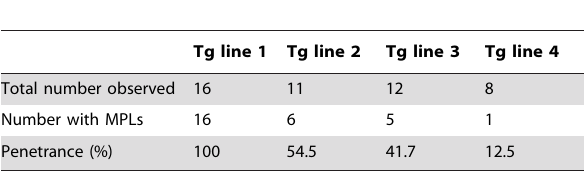
Table 1. Penetrance of melanophore proliferative lesions (MPLs) among Tg(tyr:HRAS G12V ) / Tg(hsp:cre) double-transgenic medaka derived from four different Tg(tyr:HRAS G12V ) lines (Tg lines 1 to 4).